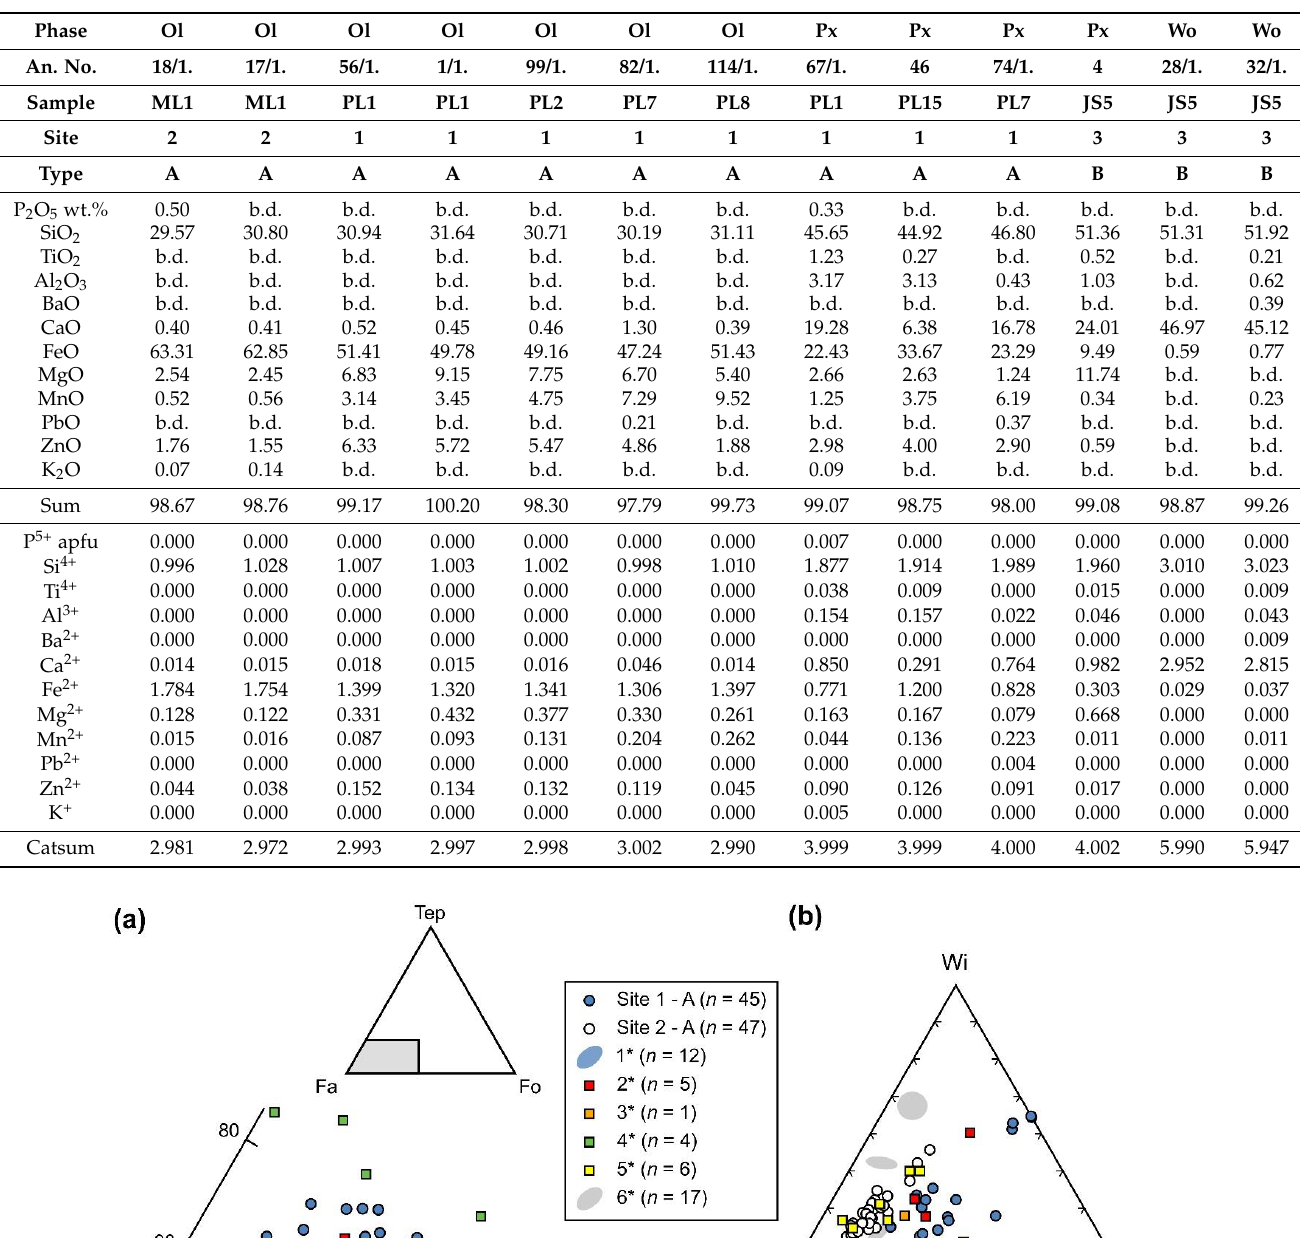
Table 3. Representative compositions of olivine, pyroxene, and wollastonite. The apfu values are calculated based on 4 oxygens for olivine, 6 oxygens for pyroxene, and 9 oxygens for wollastonite. b.d.—below the limit of detection.